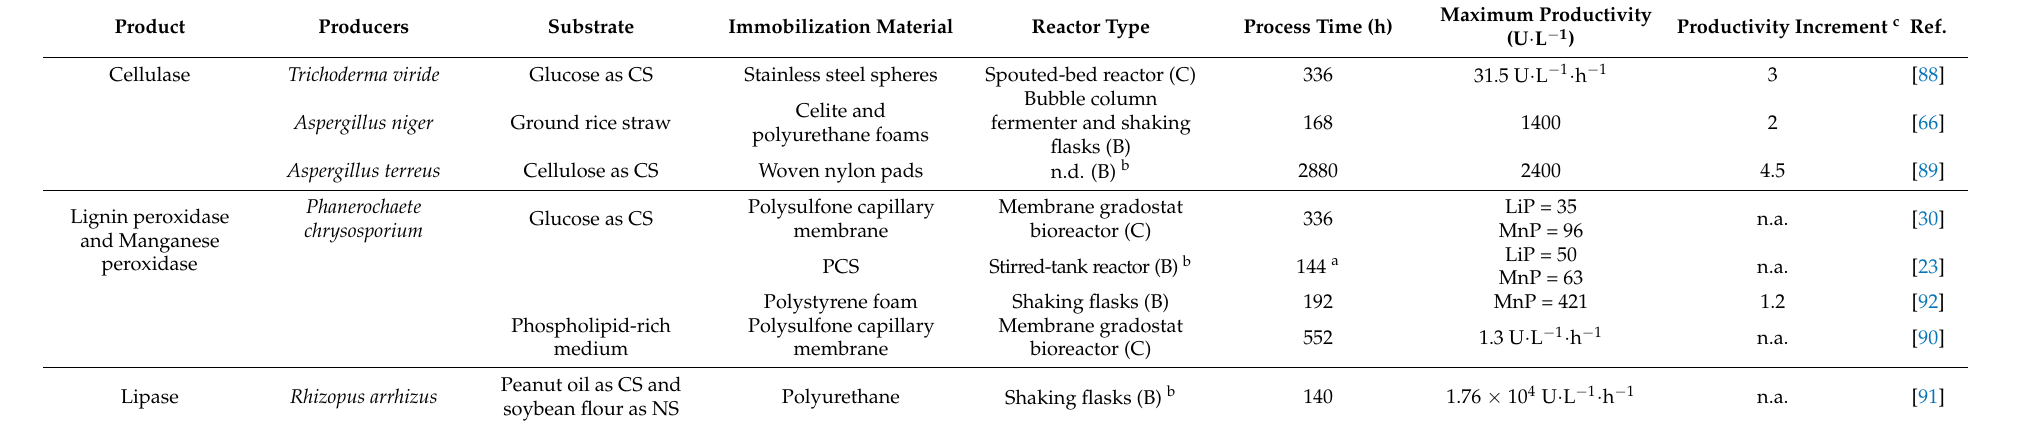
Table 2. Different classes of enzymes produced in biofilm